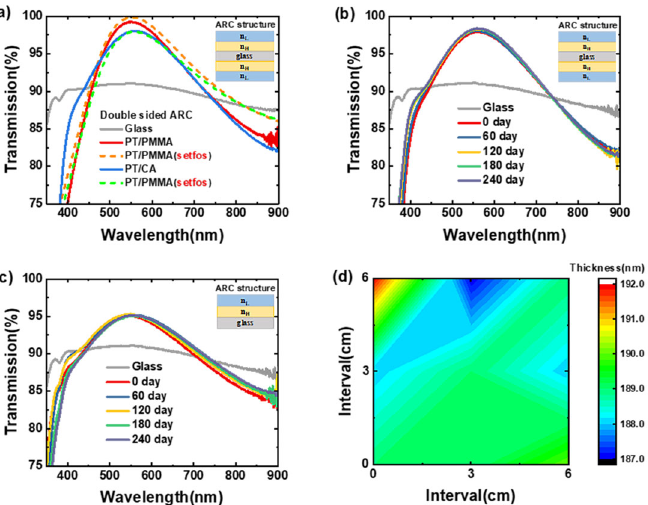
Figure 3. ( a ) Transmittance spectra of the double-sided antireflective films with large-area PT/CA and PT/PMMA structures. ( b ) Transmittance spectra of the large-area and double-sided antireflective films of PT/CA aged at different time intervals. ( c ) Transmittance spectra of the bilayer and single-sided films fabricated from the aged hybrid material solution at the same preparation conditions, taking the PT/CA structure as an example. ( d ) Thickness distribution contour plot of the single-sided and large-area antireflective films with PT/CA structure. n H : high-refractive-index hybrid PT film; and n L : low ‐ refractive ‐ index materials CA and PMMA at each side of the glass substrate.